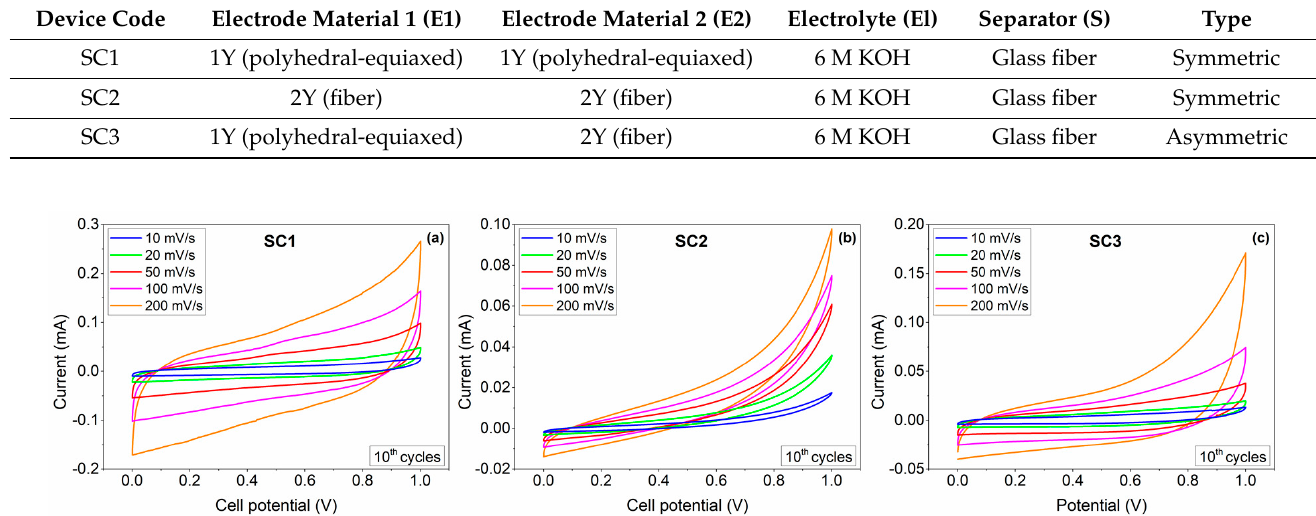
Figure 6. CV profiles of the symmetric ( a ) SC1 and ( b ) SC2 and the asymmetric ( c ) SC3 all-in-one supercapacitors at various scan rates in 6 M KOH.